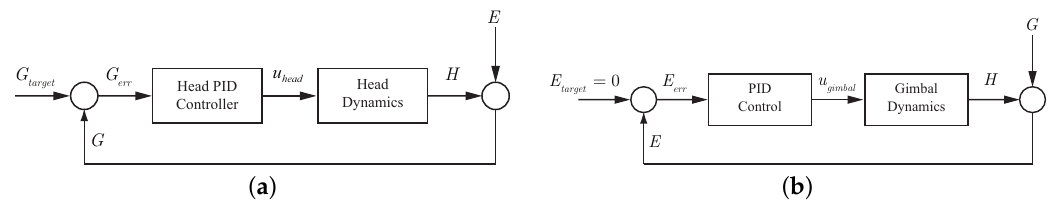
Figure 24. Block diagrams for smooth pursuit control. ( a ) Block diagram showing the structure of the head–eye control during smooth pursuit. ( b ) Block diagram showing the configuration of the smooth pursuit gimbal